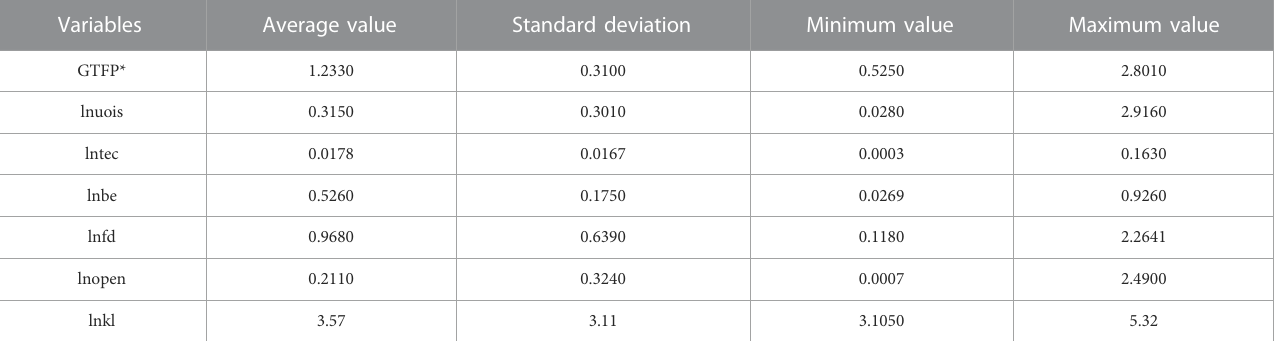
TABLE 4 Descriptive statistics of variables.